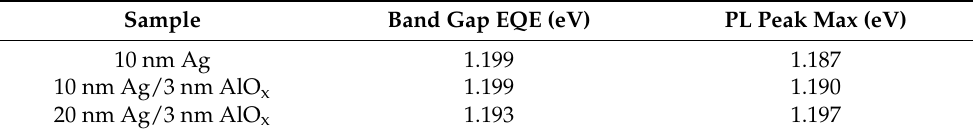
Table 1. Bandgap values from EQE and peak maxima from PL measurements.